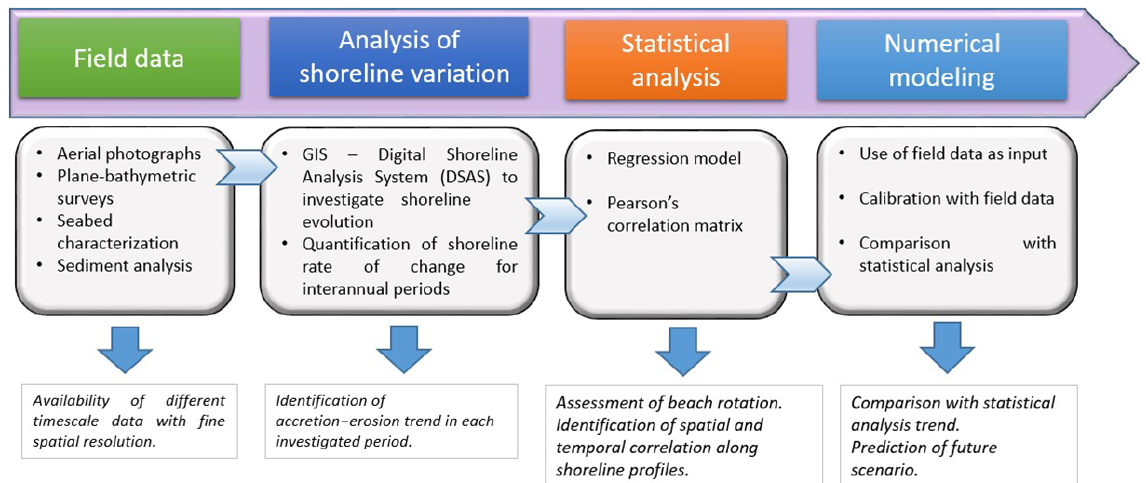
Figure 1. Sketch of the proposed approach.